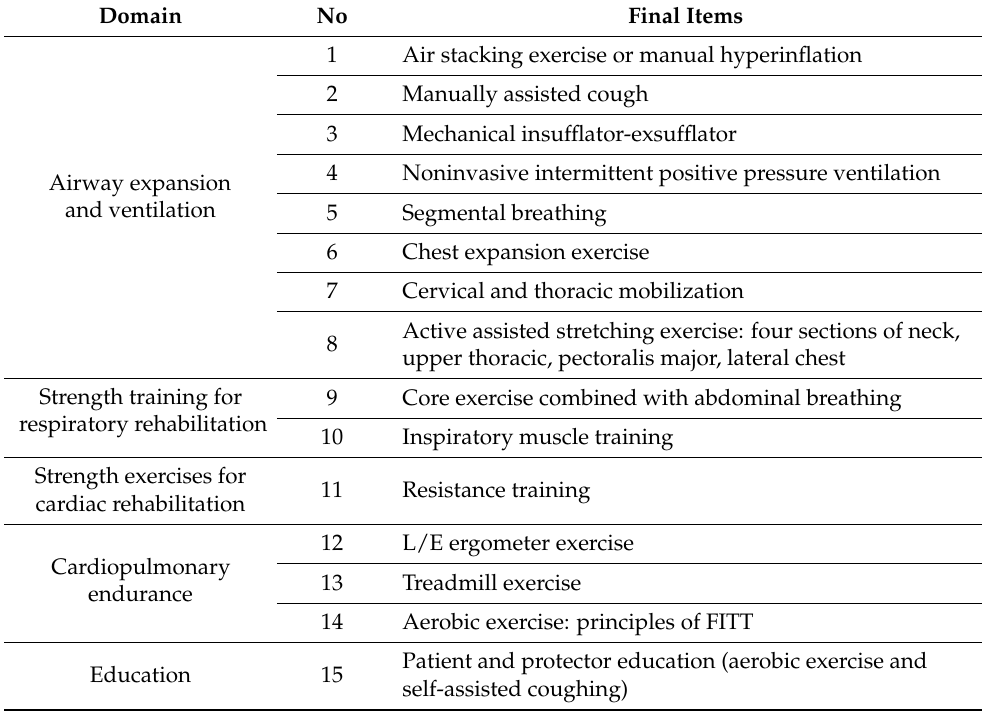
Table 5. Cardiorespiratory physiotherapy final intervention items for stroke